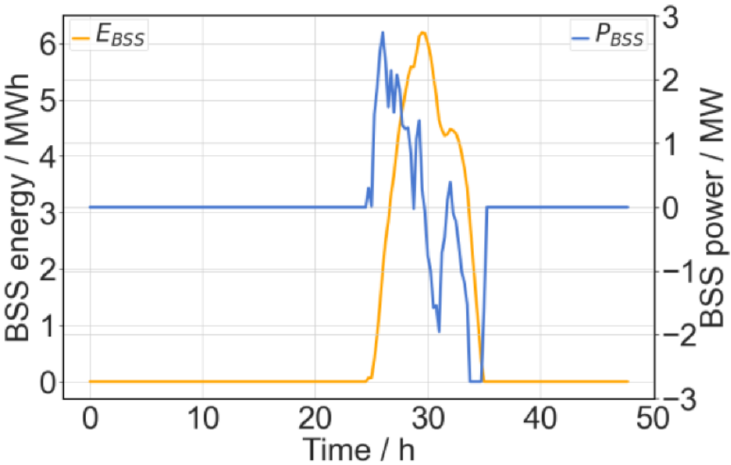
Figure 15. Charging and discharging power (blue trace) and stored energy of the BSS (orange trace). As demonstrated through Figure 16, the control of the injection power on node 5 through the application of BSS led to the compliance of the voltage magnitude with the maximal permitted voltage limit (green trace). The current flow through line 6